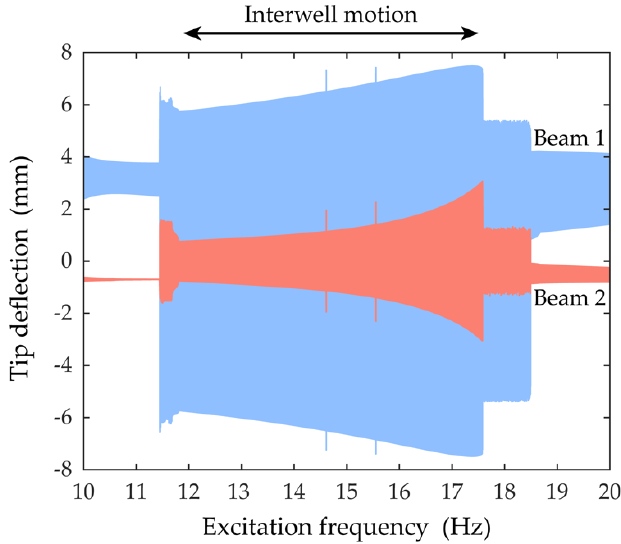
Figure 4. Swept sine response is shown. To identify the region in which attractors for interwell motion exist, the forward-sweep response is overlaid with the backward-sweep response. The marked region, from 11.9 to 17.5 Hz, above the graph indicates where the regular attractors for interwell motion exist. The amplitude of the excitation was set to be 6 m/s 2 .